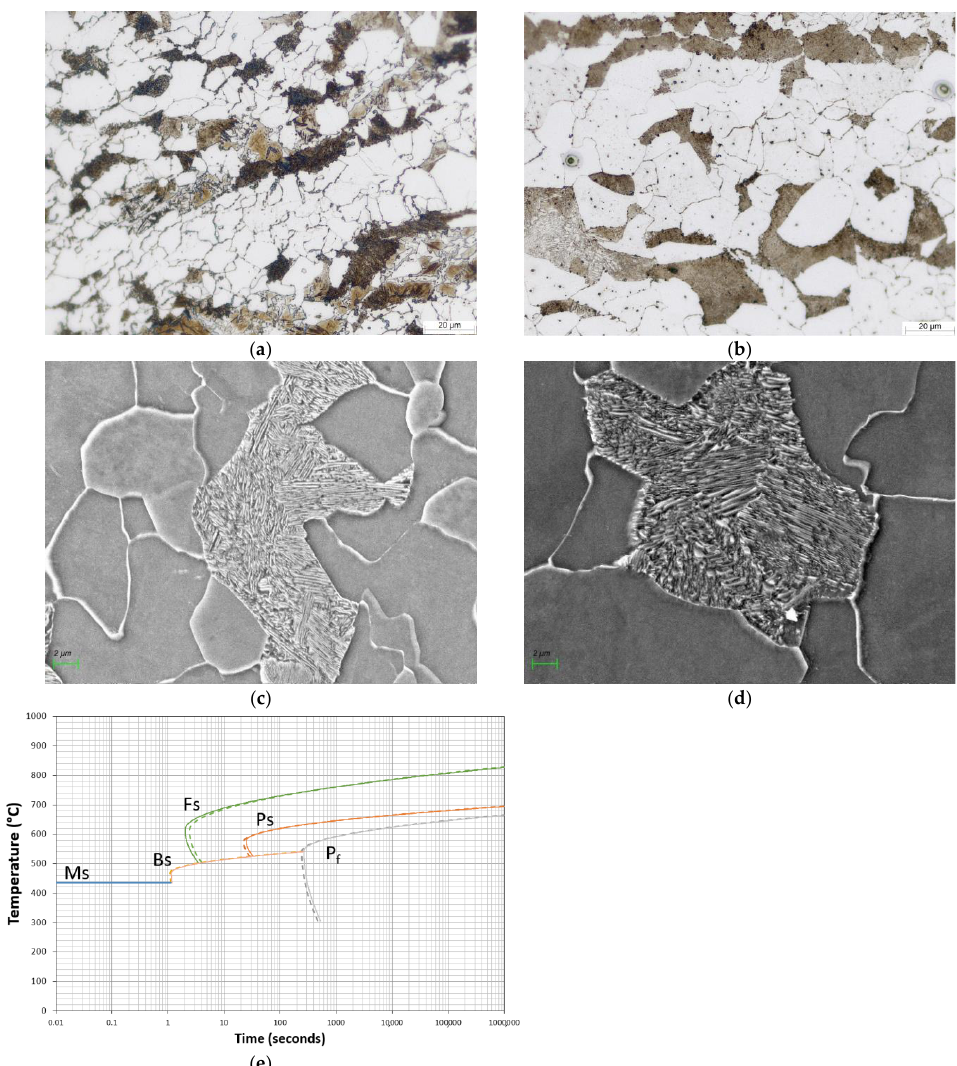
Figure 6. LOM: ( a ) with Nb (240 Nb) and ( b ) without Nb (0 Nb). Etchant: Nital 4%. Enlargement: 500×. Observation: perpendicular to the main rolling direction. FE-SEM using SE2 detector: detail of typical secondary phase (within pearlite) in the ( c ) 240 Nb sample and ( d ) 0 Nb sample. Enlargement: 8000×. ( e ) Predicted CCT based on internal experimental database with Nb (dashed line) and without Nb (full line) and non-deformed PAG.